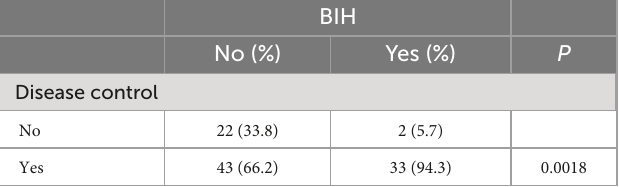
TABLE 3 Association between BIH (Bevacizumab-Induced Hypertension) and first-line bevacizumab-based chemotherapy. BIH